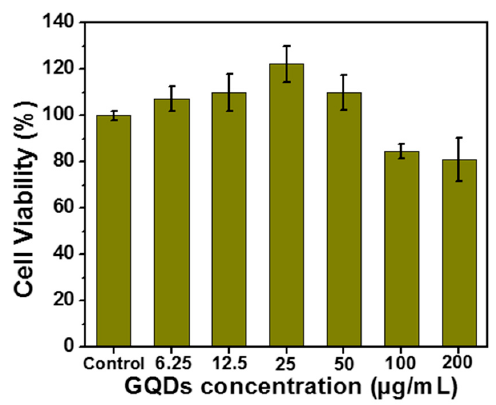
Figure 7. WST-1 assay on THP-1 cell line when varying the concentration of GQDs from 6.25 to 200 µg/mL.Values represent means ± S.E ( n = 3).